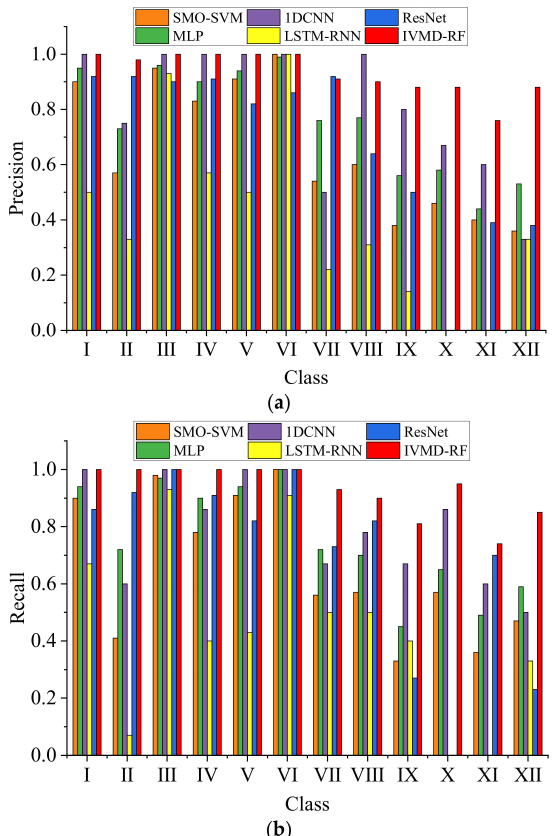
Figure 9. Precision and recall results of each algorithm for the 3H dataset. ( a ) Precision result. ( b ) Recall result.